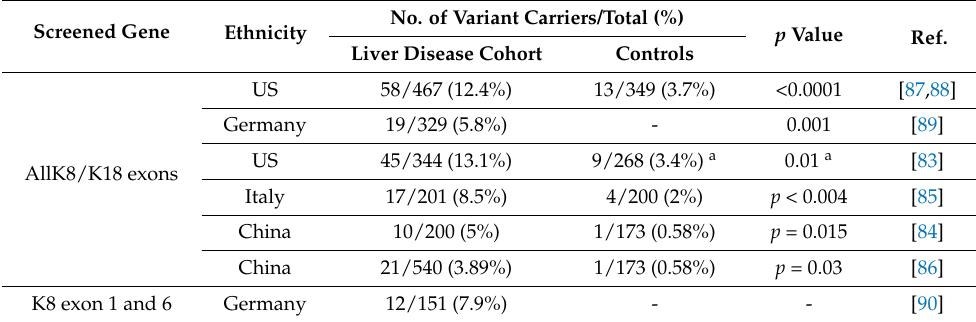
Table 4. Comparison of keratin variant frequency in patients with liver diseases and controls.